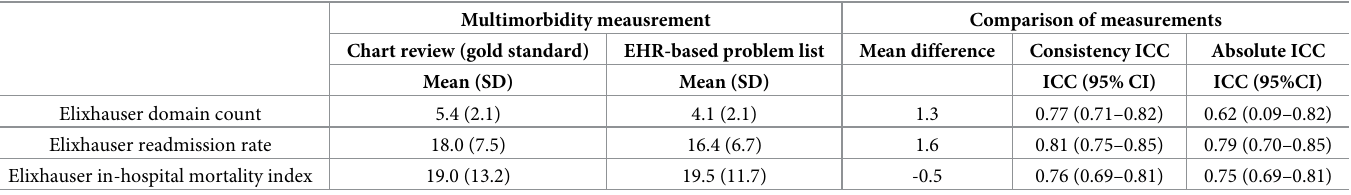
Table 4. Comparison Elixhauser multimorbidity measures by chart review and EHR-based problem list. Multimorbidity